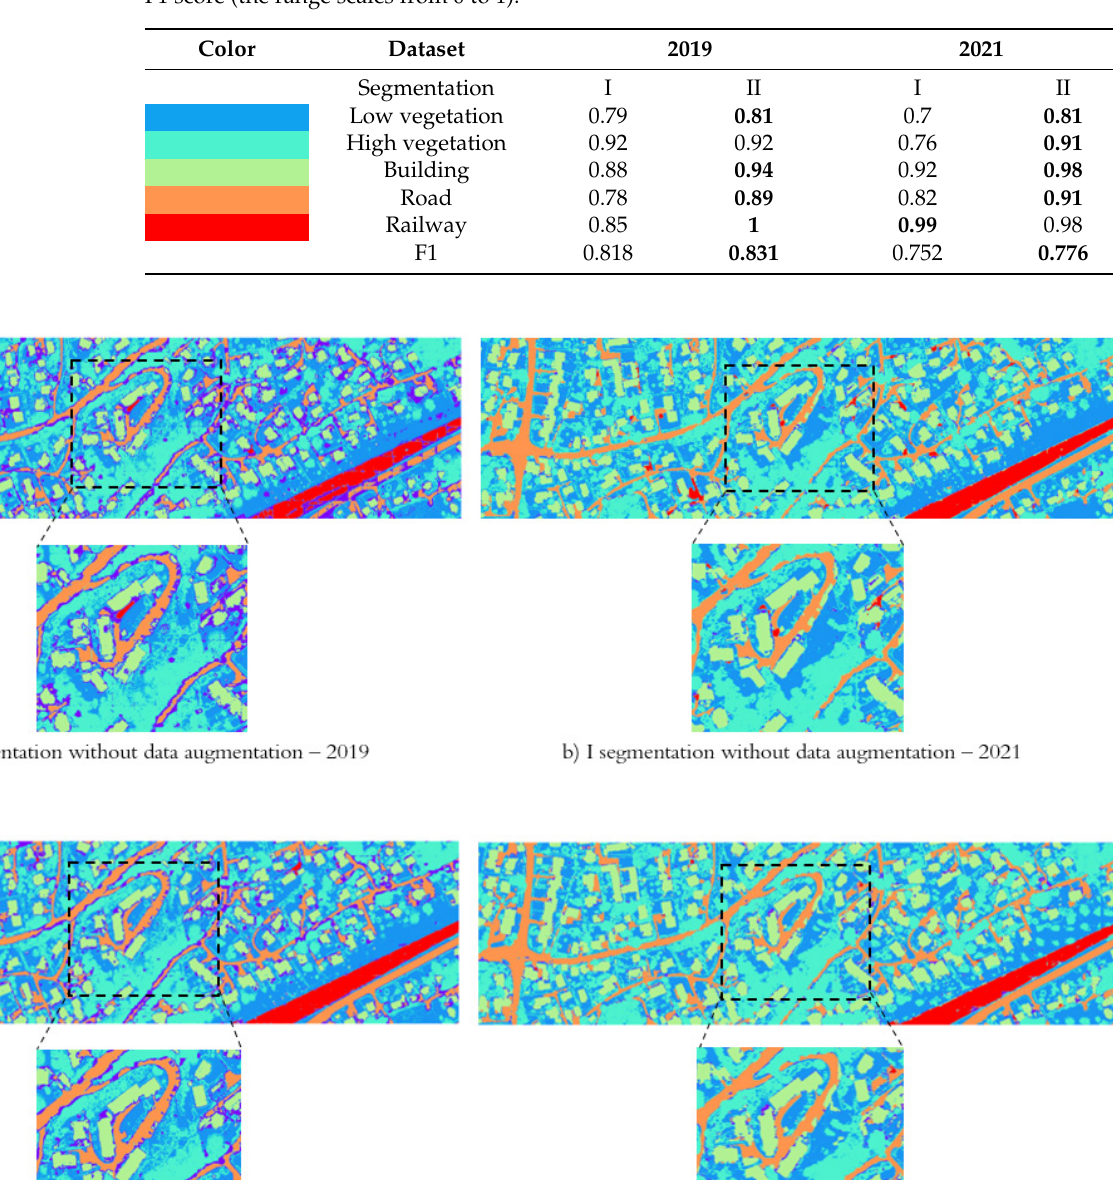
Table 2. Segmentation results without data augmentation for the dataset from 2019 and 2021 for the ResU-Net model based on MCC calculated for each class (the range scales from − 1 to 1) and overall F1 score (the range scales from 0 to 1).